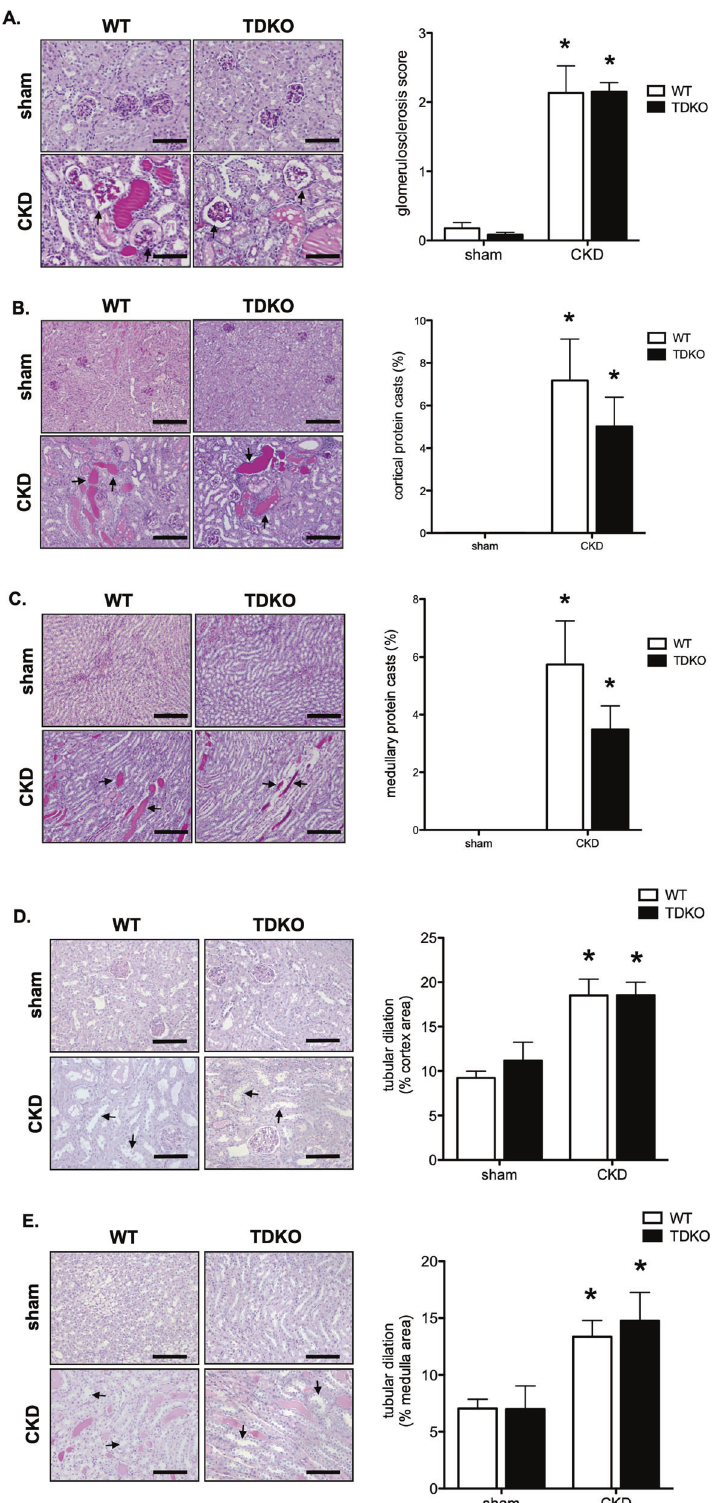
Fig. 3 TDKO mice are not protected from glomerulosclerosis or tubular injury. Kidneys from WT and TDKO mice with or without chronic kidney disease (CKD) were examined for structural damage. A Glomerulosclerosis is increased in CKD animals, but there is no difference between WT and TDKO mice. Bar = 100 μ m. Formation of protein casts is increased in the cortex ( B ) and medulla ( C ) of WT and TDKO mice with CKD. Tubular dilation was increased in the cortex ( D ) and medulla ( E ) of mice with CKD, and was not different between WT and TDKO mice. Bar = 200 μ m. * P < 0.05 vs